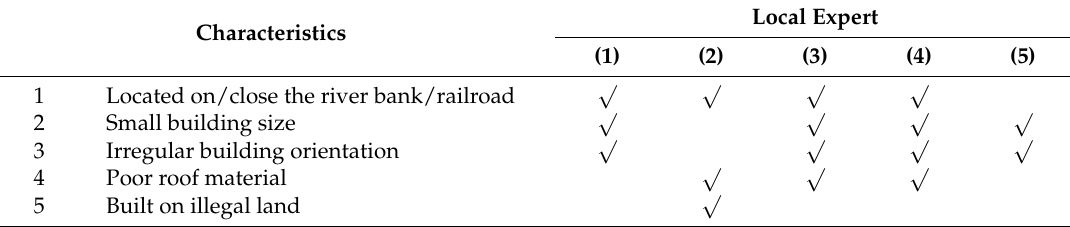
Table 1. Different characteristics and definitions of slums among local experts. (1) is from the central government; (2) is from the local government; (3) is from Non-Government Organization (NGO), and (4) and (5) are housing policies